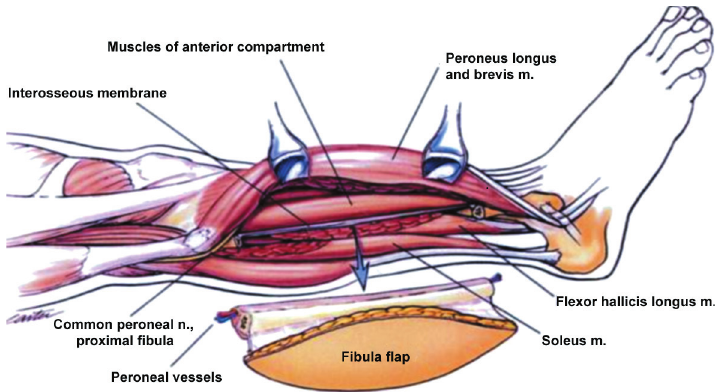
Figure 3- Lateral view of the right leg. Note the proximity of the common peroneal nerve to the proximal osteotomy, according to Anthony and Foster 6 (1996)